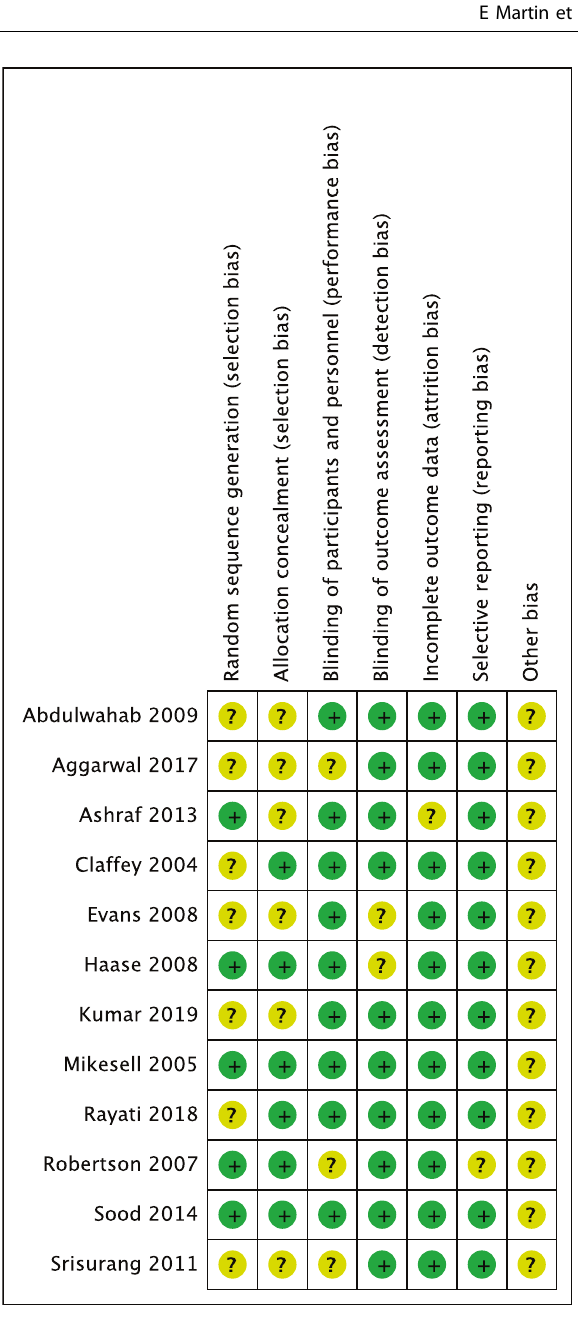
Fig. 2 Risk of bias